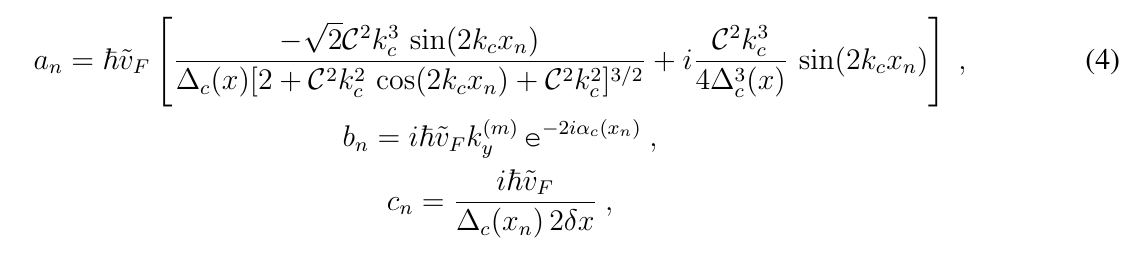
k ) in the absence of electron F SAW k ) for semiconducting F SAW